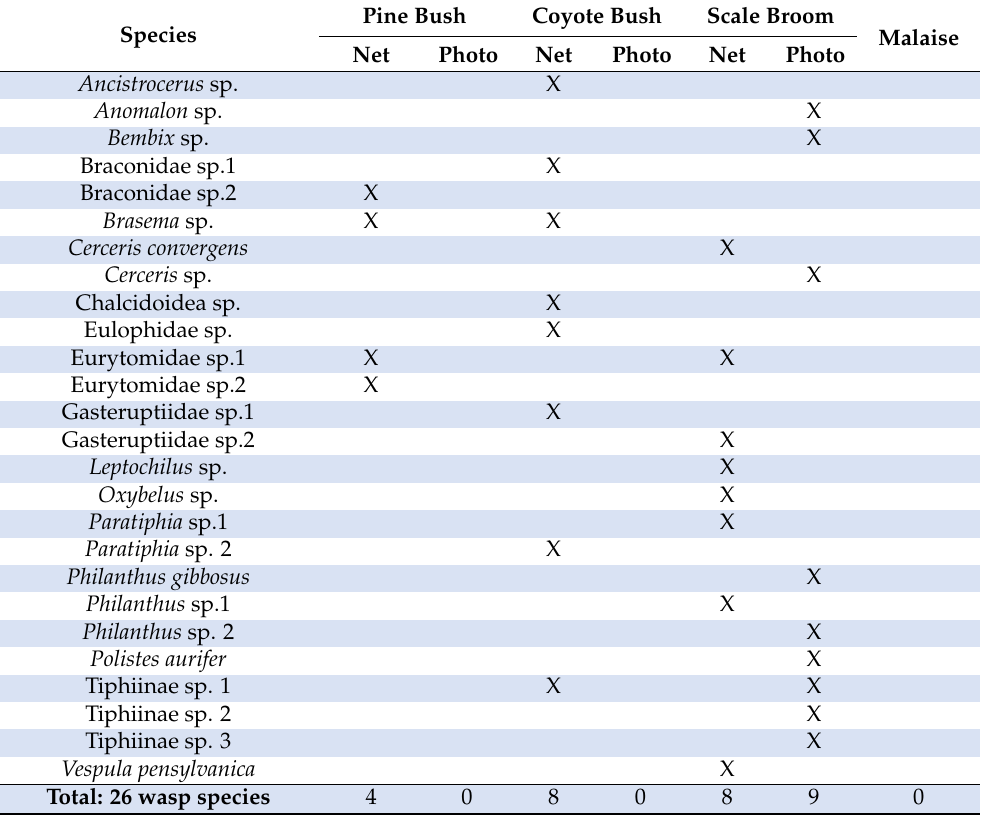
Table 6. Hemipterans of E. pinifolia (pine bush), B. pilularis (coyote bush), and L. squamatum (scale broom). Pine Bush Coyote Bush Scale-Broom Species Net Photo Net Photo Net Photo